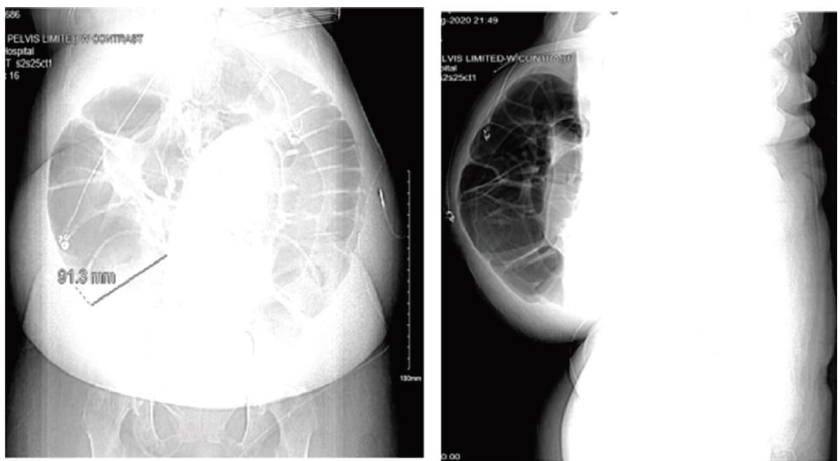
Figure 1: CAT scan with intravenous contrast showing dilated loops of